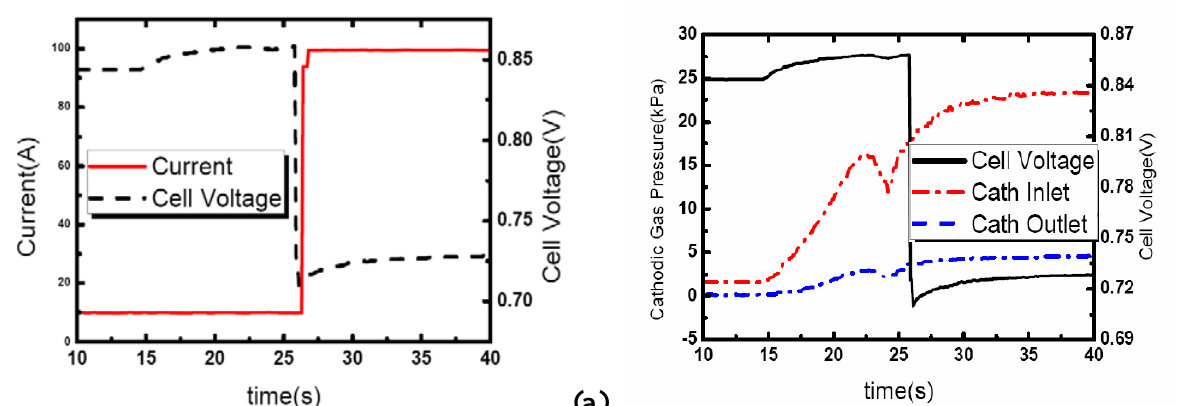
Figure 14. Dynamic response when in delayed loading-up mode for (a) current and voltage (b) cathode gas